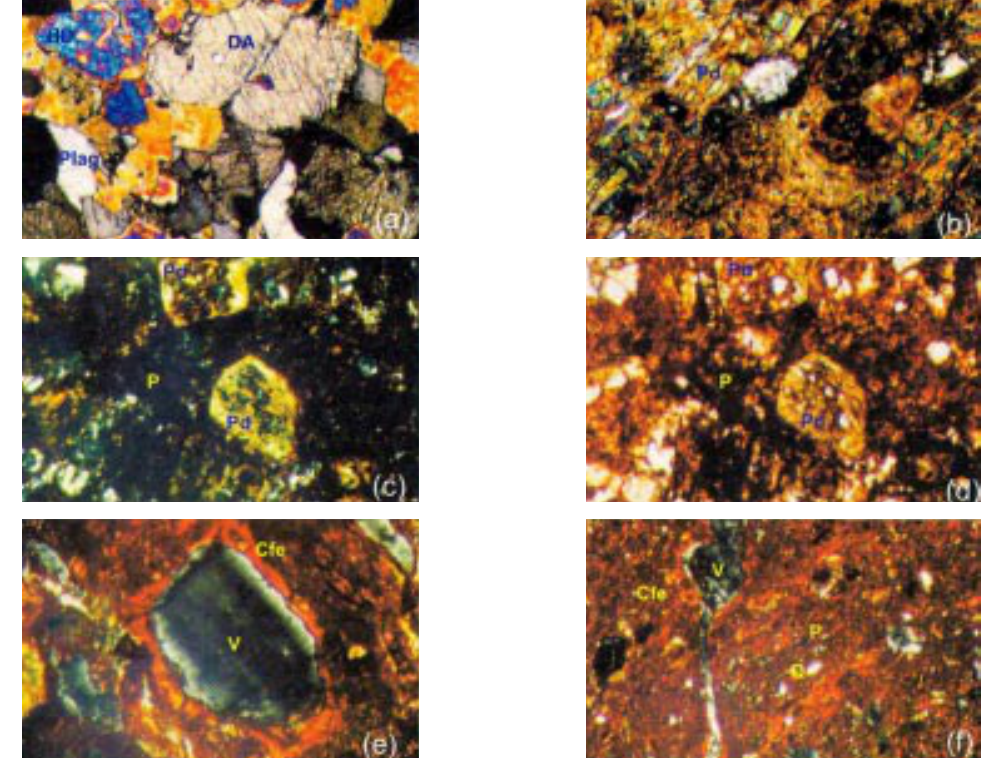
Figura 3. Microfotografias ao longo do perfil 3 - Chernossolo Argilúvico. (a) Fácies rocha fresca (DA = diopsídio-augita, HD = hornblenda-edenita, Plag = plagioclásio); (b) Fácies alterito-horizonte (Pd = pseudomorfos de DA e HD, processos de argilização e ferruginização); (c) Fácies de transição C 2 - horizonte BC (Pd = pseudomorfos de DA e HD, evolução dos processos de argilização e ferruginização) em nicóis cruzados; (d) Idem (c) em nicóis paralelos; (e) Fácies de transição-horizonte BC (V = vazios- litoporos, Cfe = cutans - ferriargilans e ferrans indicativos de processo de iluviação); (f) Fácies sólum - horizonte Bt (Q = quartzo - esqueleto, V = vazios, P = plasma a argilominerais silicatados + sesquióxidos de Fe, Cfe = cutans - ferriargilans e ferrans, indicativos de processo de iluviação). (Obj 6.3x; Oc